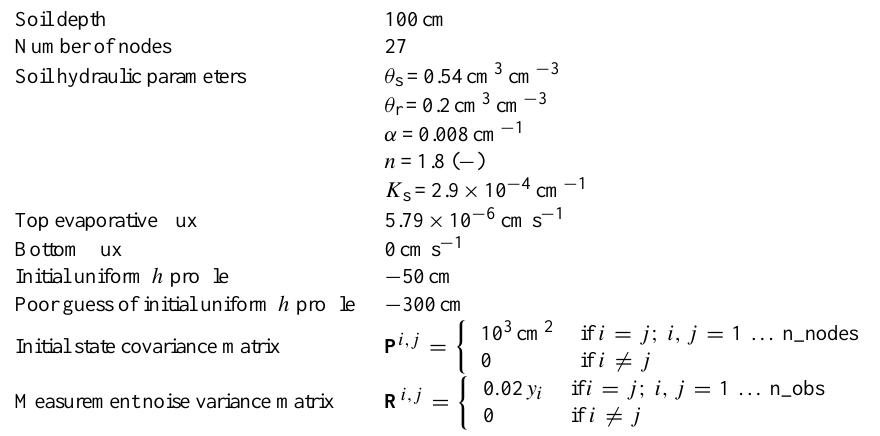
Table 2. Parameters and conditions employed in the synthetic generation of matric pressure head profiles and for the initialization of the assimilation